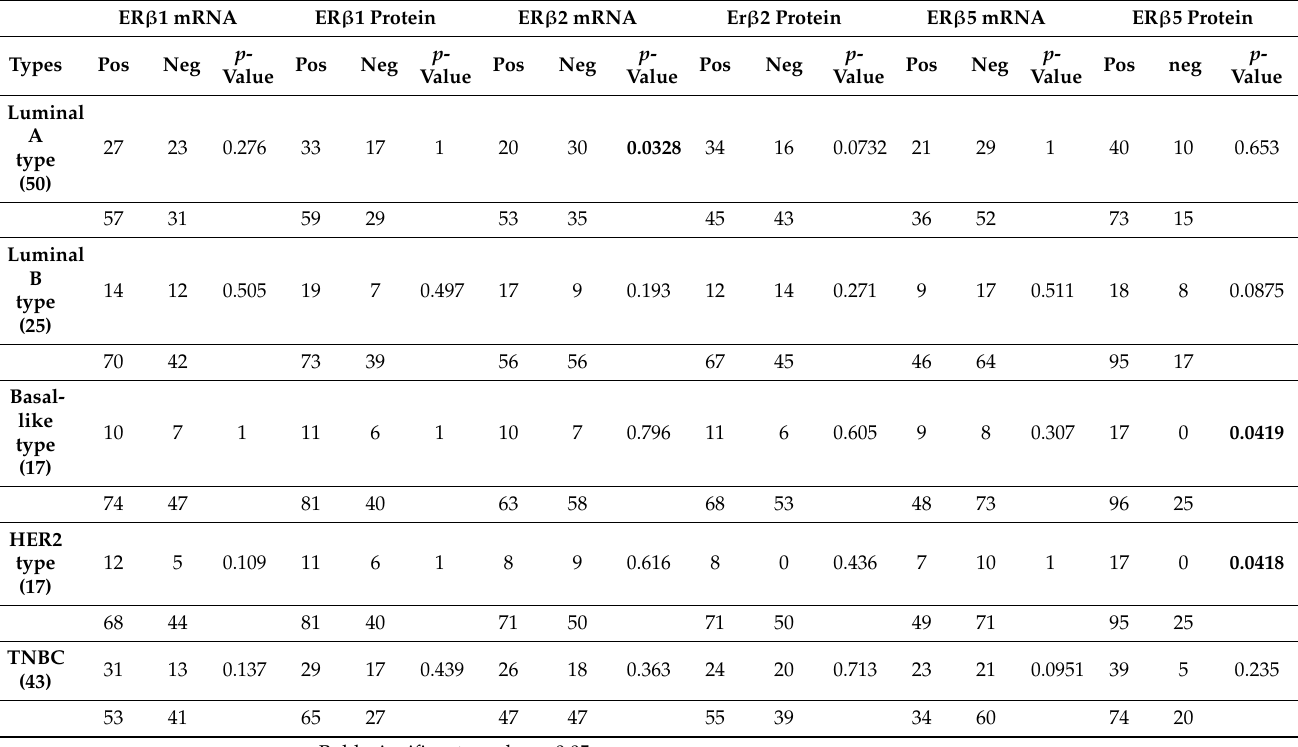
Table 3. Associations between ER β isoform mRNA and protein expression and molecular types.